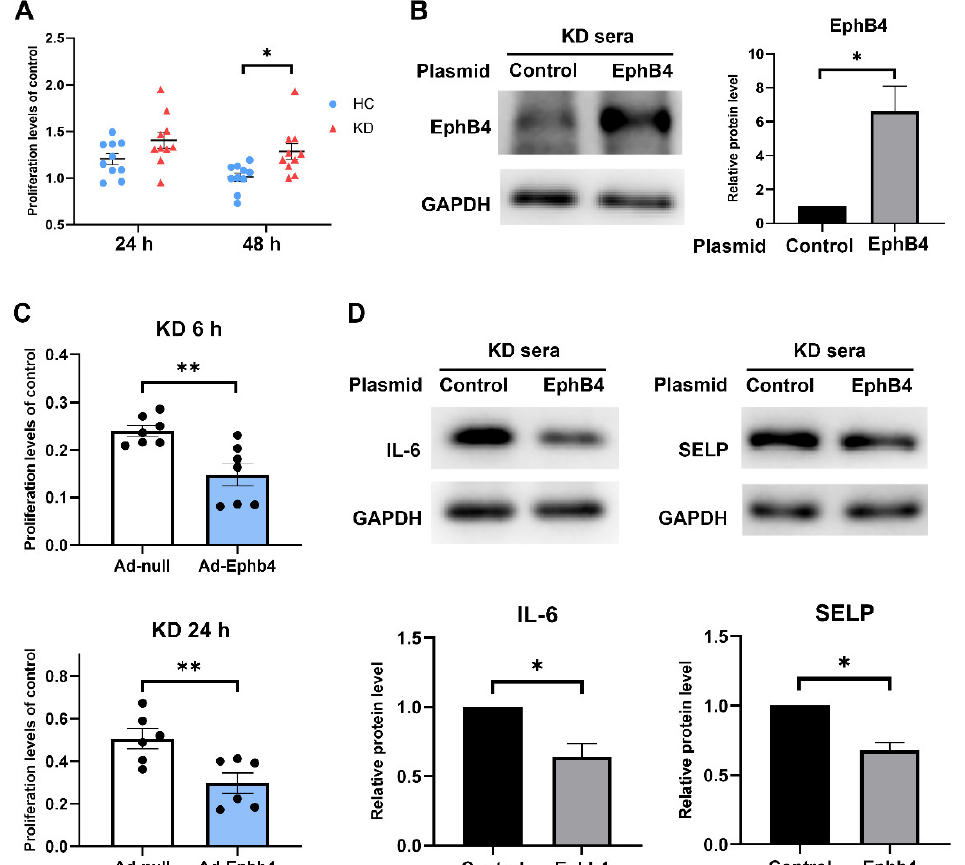
Figure 4. Overexpression of EphB4 suppressed KD-induced high cell viability and inflammation. ( A ) HCAECs were incubated in medium containing 15% sera from HC or KD. After 24 h and 48 h, cell proliferation was detected by CCK-8. ( B ) HCAECs were transfected with EphB4 or ctrl plasmid for 24 h and then incubated in 15% KD sera for 6 h. Then, the protein level of EphB4 was detected by Western blot. ( C ) HCAECs were transfected with plasmid for 24 h and then incubated in 15%